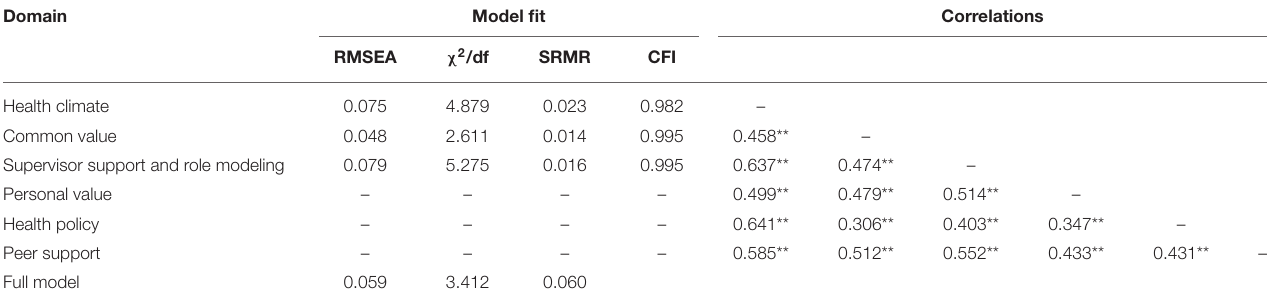
TABLE 4 | Corrections among constructs.